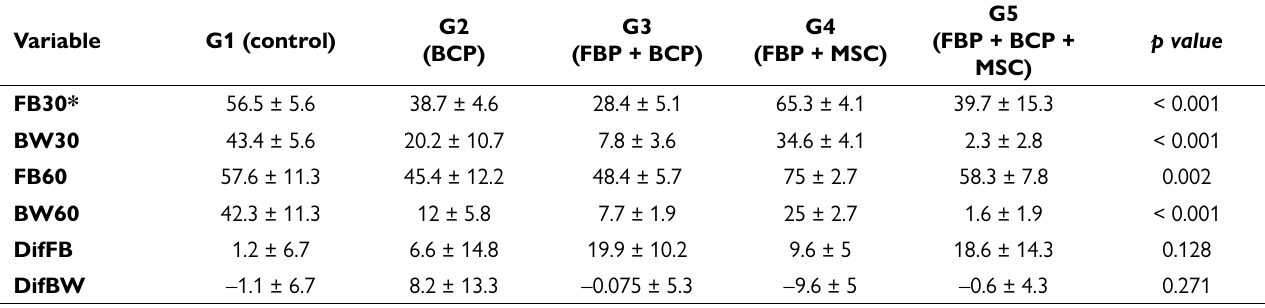
Table 2. Statistical comparison among groups by ANOVA test. Data presented by mean and standard deviation.